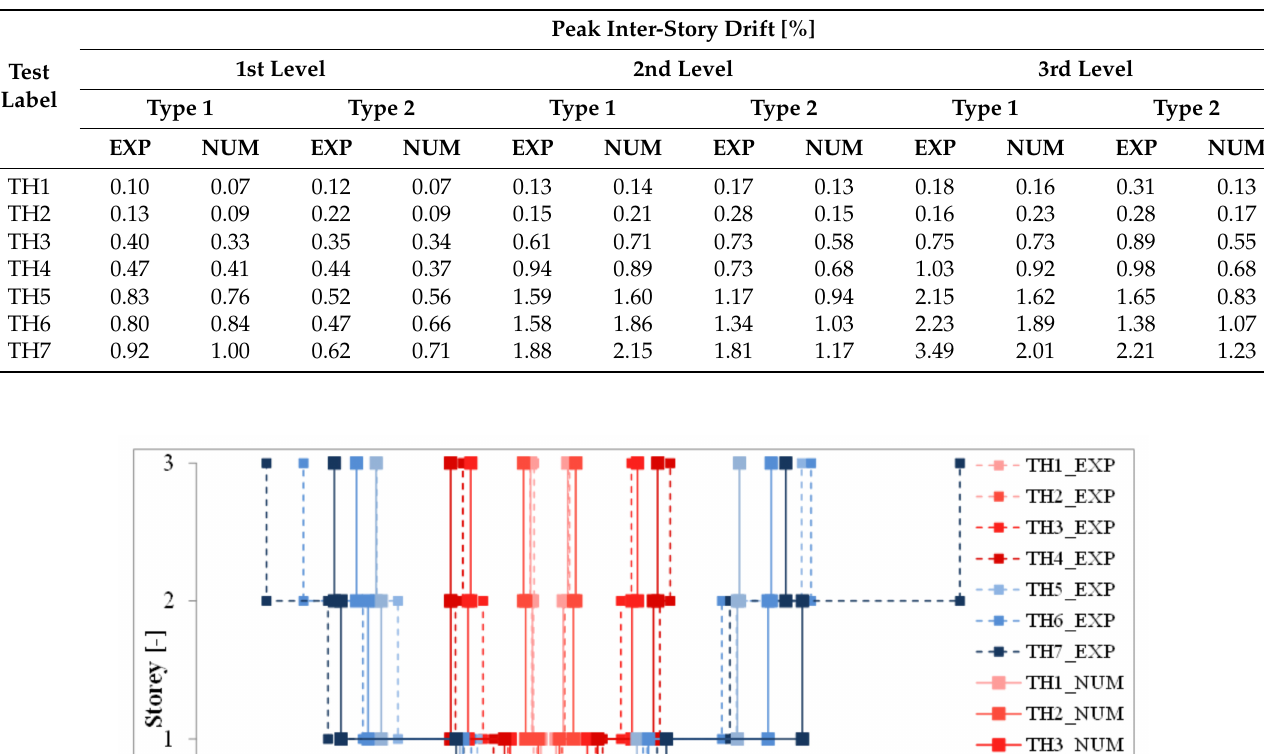
Table 4. Comparison in term of fundamental periods of vibration.